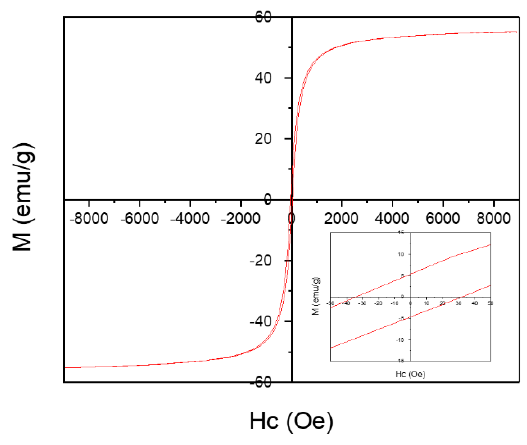
Figure 4. VSM of the prepared MgIONPs@TMAH.